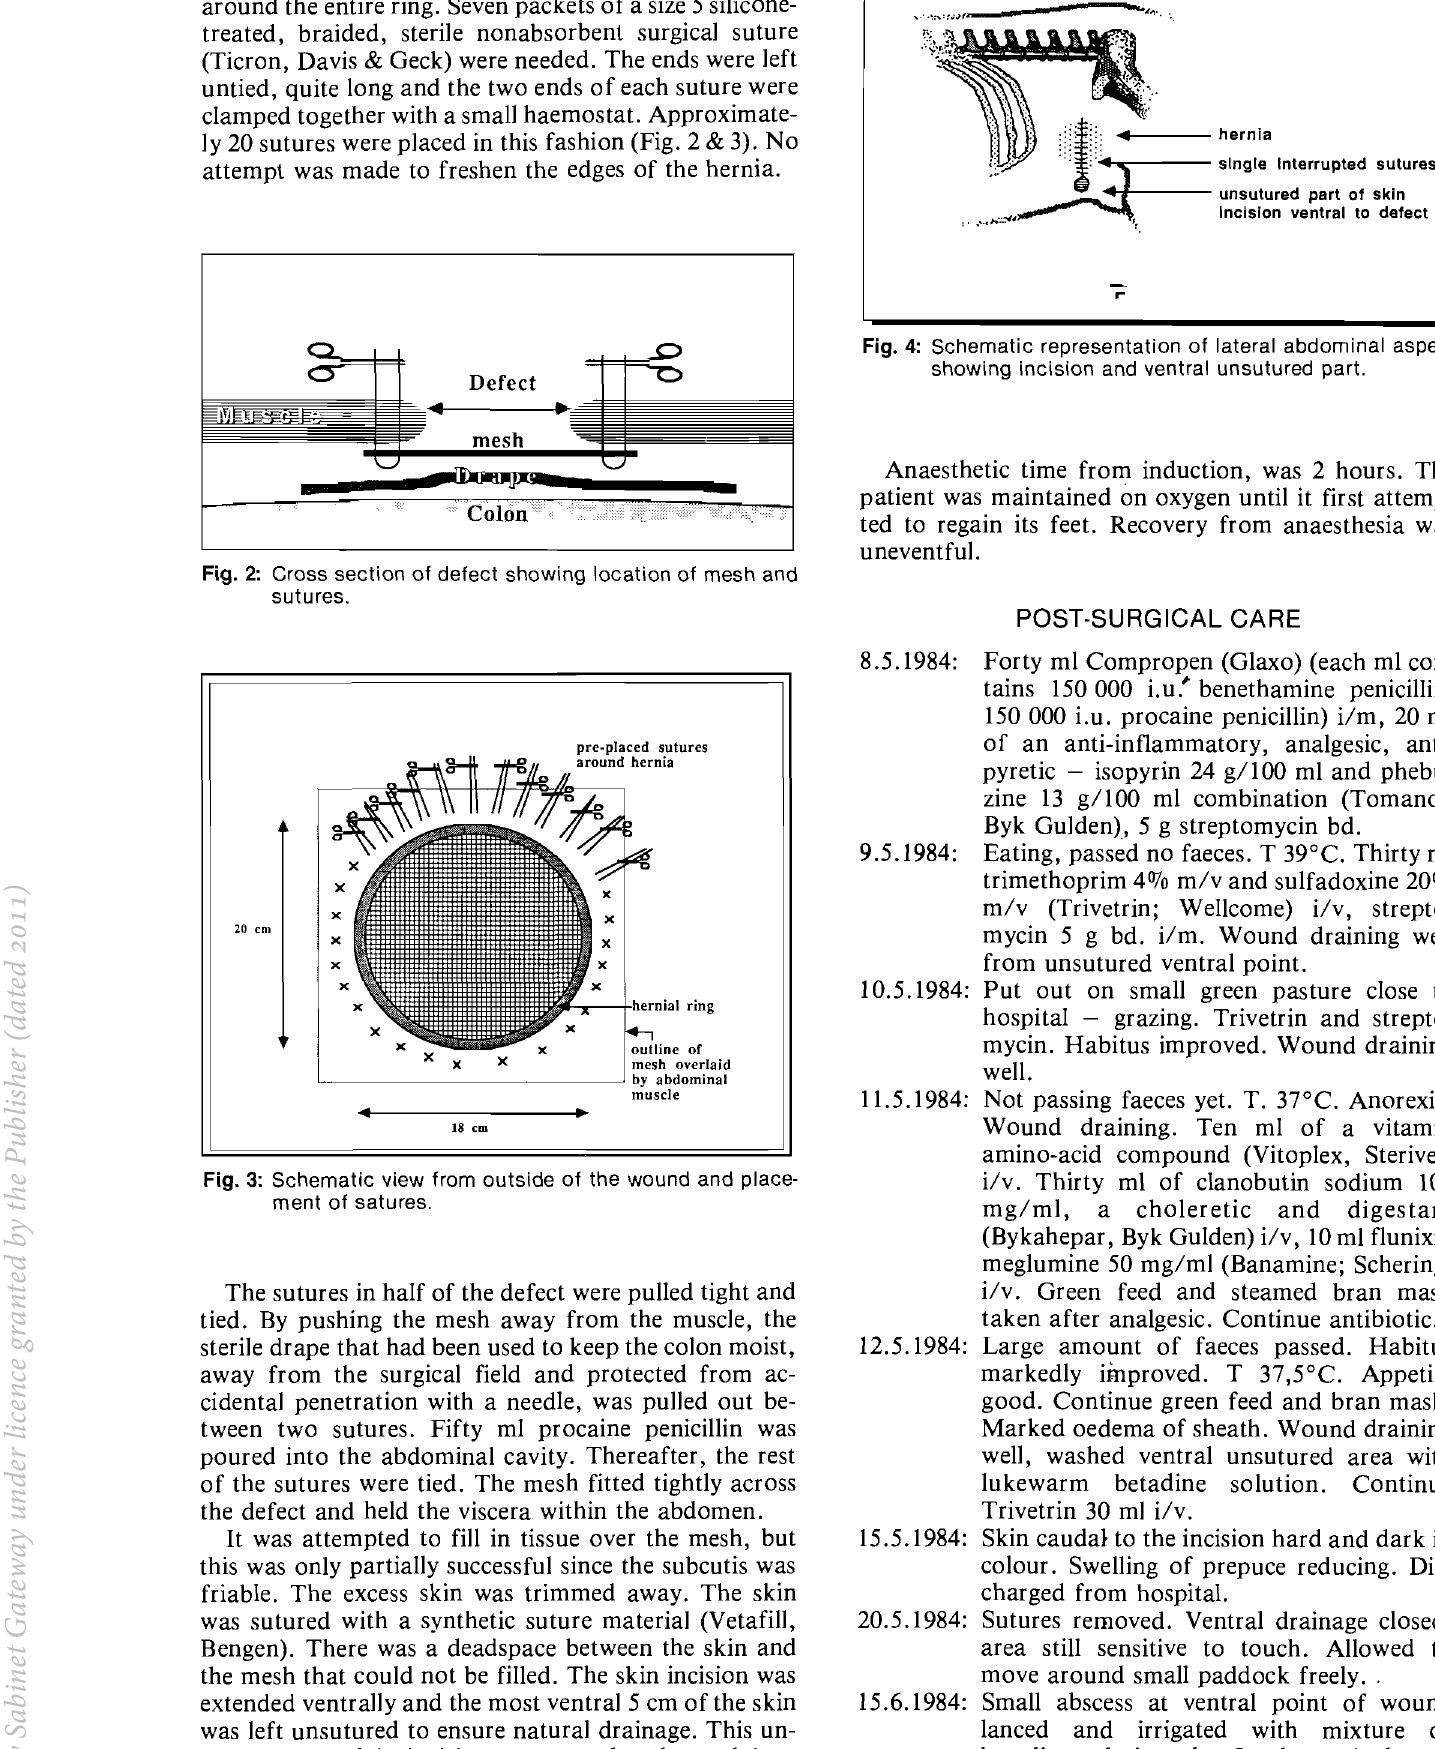
Fig. 4: Schematic representation of lateral abdominal aspect showing incision and ventral unsutured part.